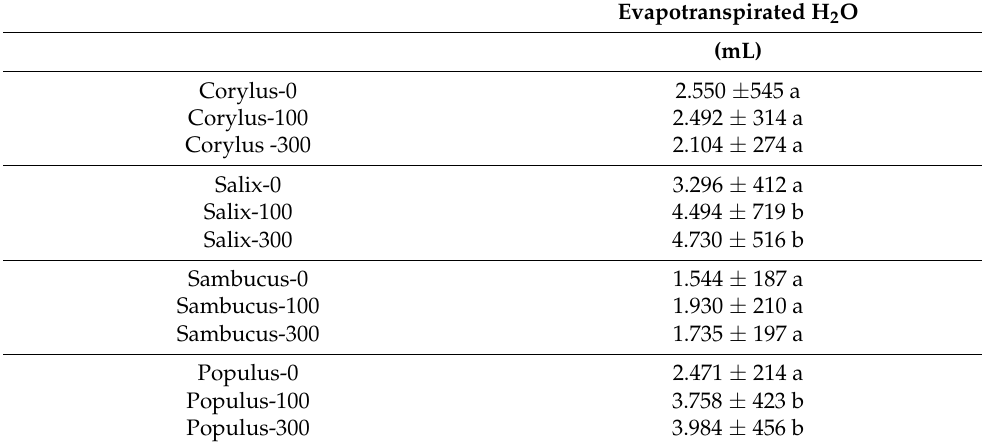
Table 4. Cumulated evapotranspirated water by Corylus, Salix, Sambucus and Populus treated with the tree NO 3 − concentrations in hydroponic nutrient solution at 21 days after the treatment (DAT).